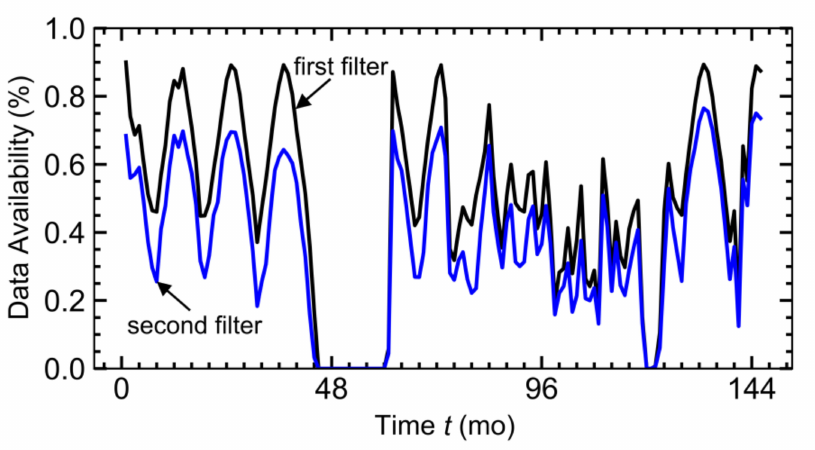
Figure 5. Availability of the ase170St multi-c-Si PV system in Stuttgart, Germany after the first initial filtering in black and the second filtering in blue. Time series periods with no usable data are marked as zero availability.